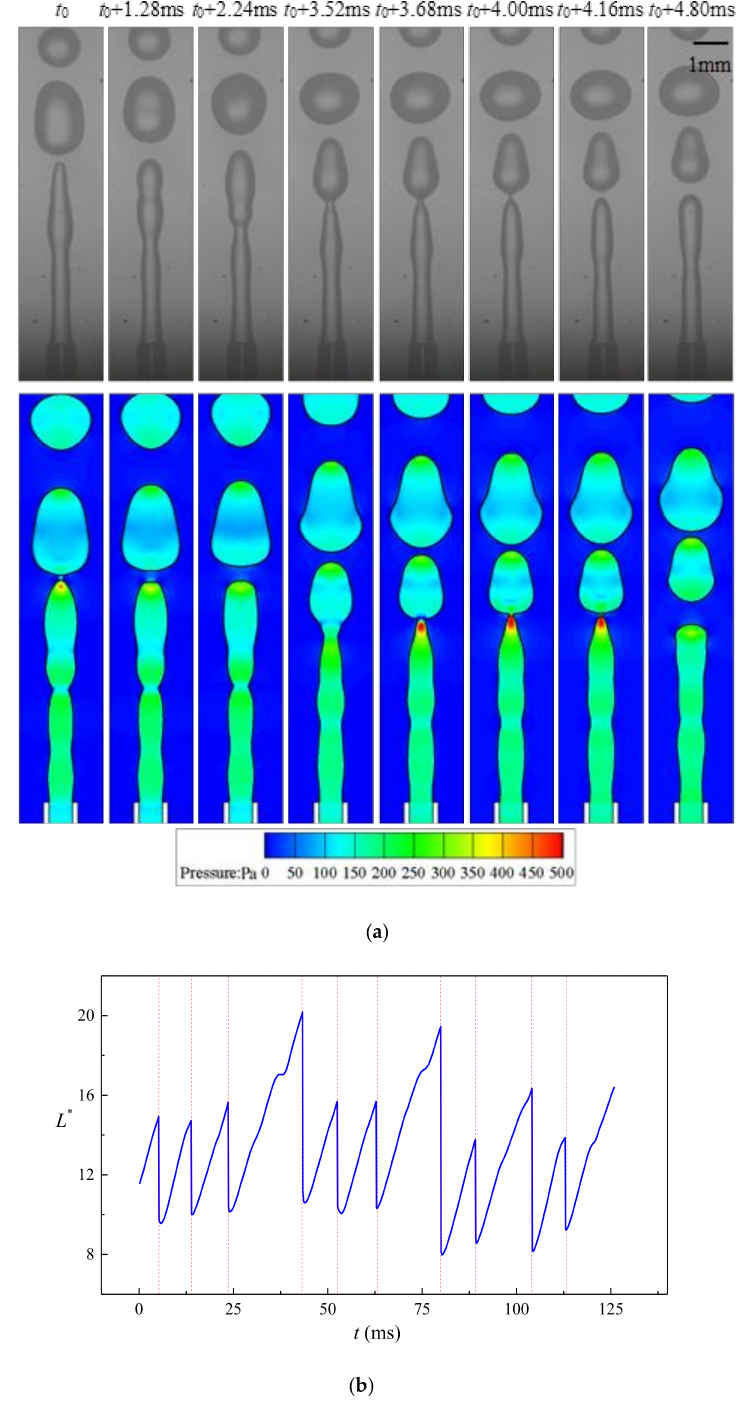
Figure 7. Typical jetting regime ( q d = 355 mL / h, We = 0.42, Bo = 0.0038): ( a ) experimental snapshots and numerical simulation; ( b ) variation of droplet length reconstructed from numerical